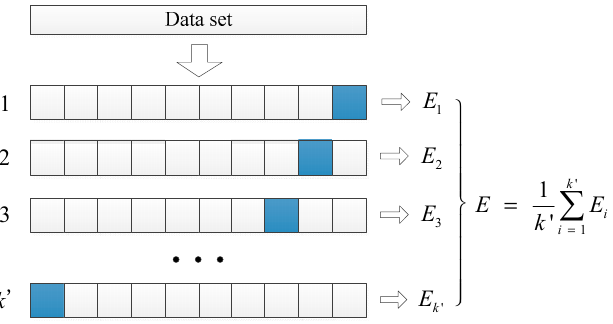
Figure 1. Procedure of 𝑘 (cid:4593) -fold cross-validation.